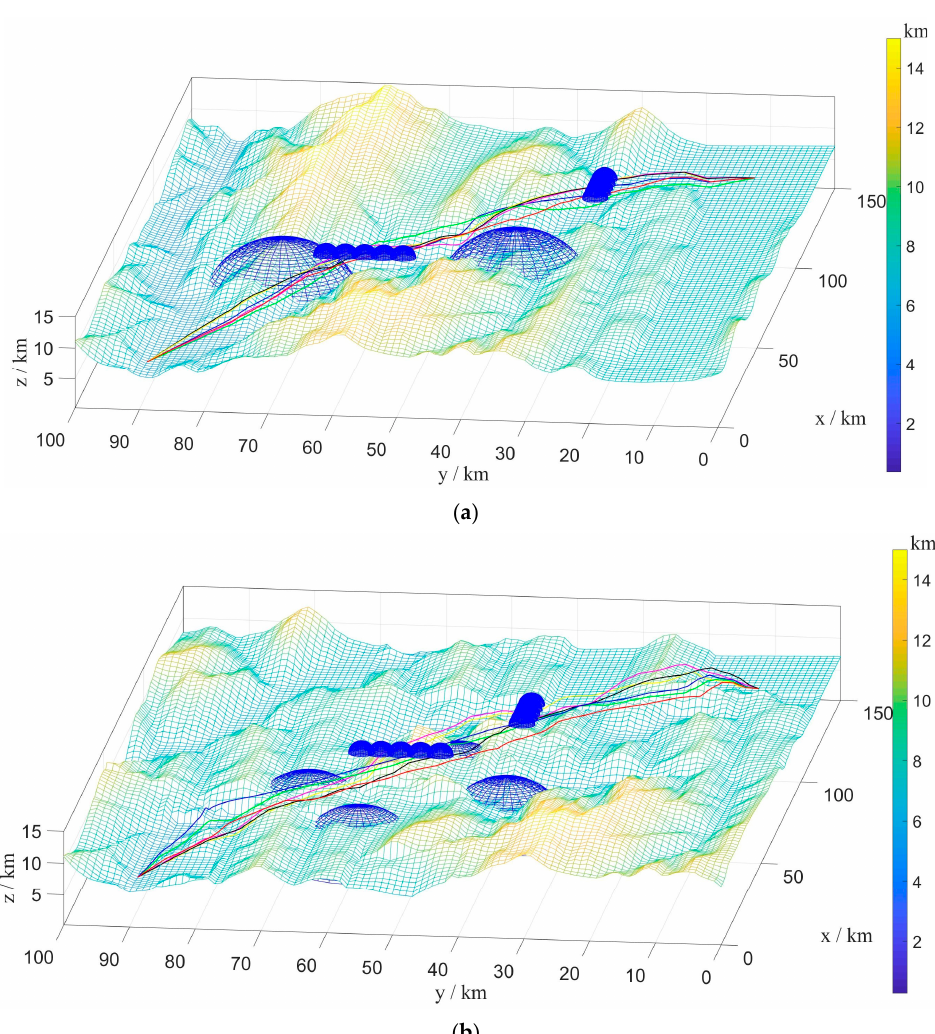
Figure 16. Multi-UAV path planning results of BINN-HHO on a 3D simulation map. ( a ) Dynamic case I. ( b ) Dynamic case II.